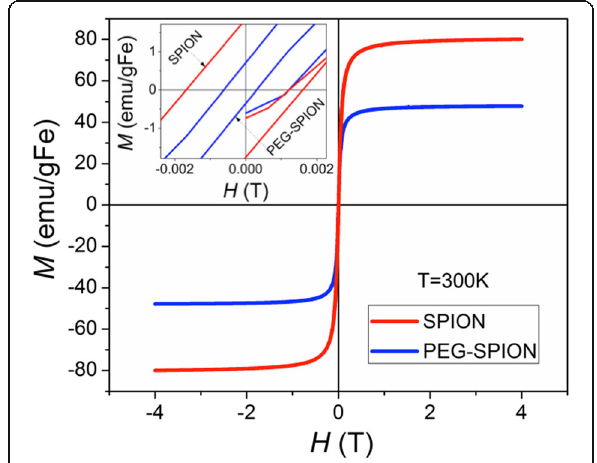
Fig. 5 M-H hysteresis curves of SPION and PEG-SPION. The inset shows the values of MR and HC for SPION and PEG-SPION at low magnetic